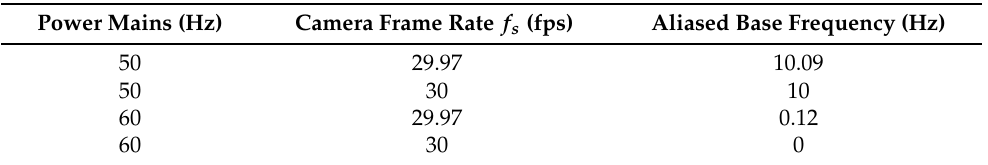
Table 1. Aliased frequencies of ENF with respect to (w.r.t.) camera frame rate and fundamental ENF at power mains frequency